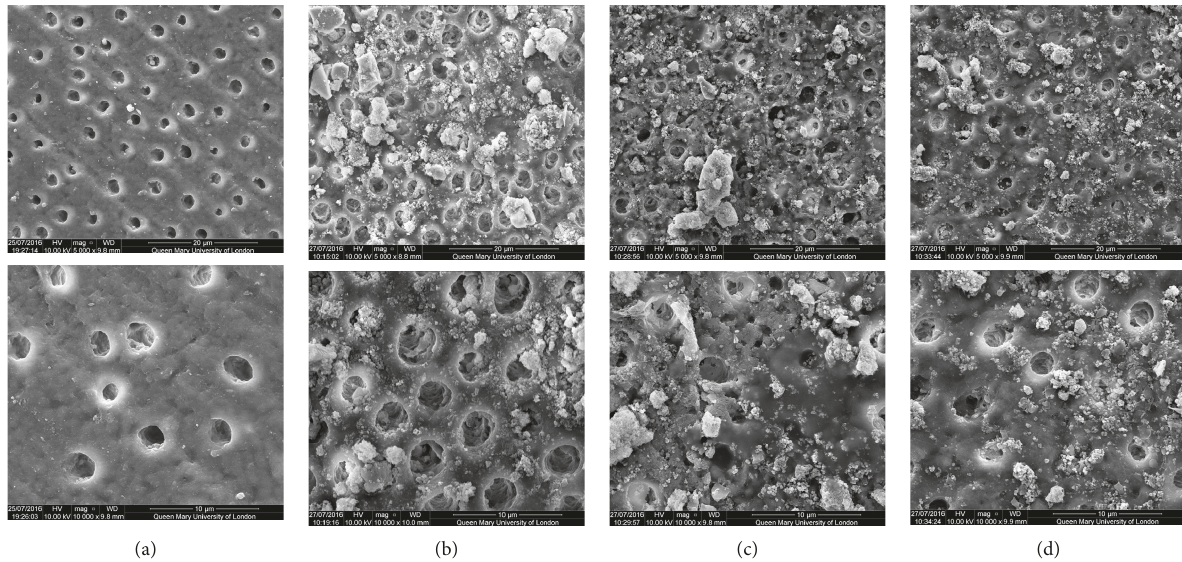
Figure 4: SEM images of the dentine surface morphology in disc 4 treated with a chloride glass-based toothpaste at 5000x (top) and 10000x (bottom) magnifications. (a) Control; (b) after brushing with a bioactive glass-based toothpaste; (c) after brushing with a bioactive glass- based toothpaste+artificial saliva immersion for 1 hour; (d) after brushing with a bioactive glass-based toothpaste+acid challenge with 6% citric acid.